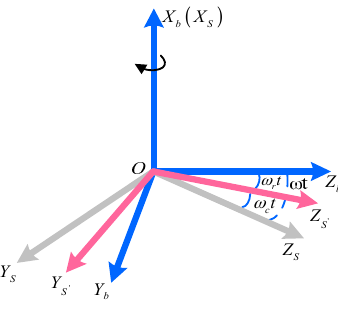
Figure 4. The relationship between B-frame, S’-frame and S-frame.